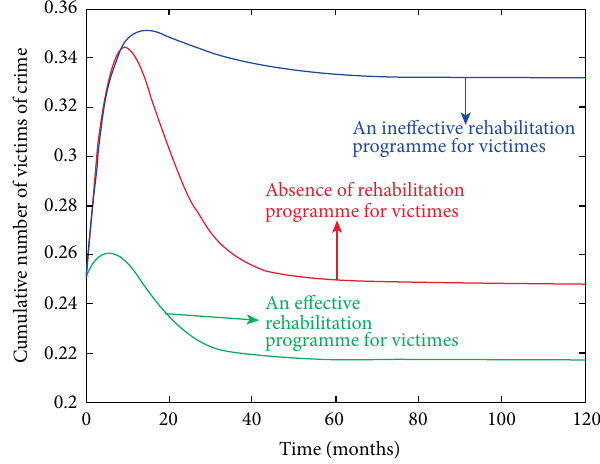
Figure 7: Simulation of model (4) showing the impact of a victim rehabilitation programme for victims of crime on criminality as observed from a combination of variable values of density of victimisation/victims of crime as a function of time. Other parameter values used are as in Table 3.